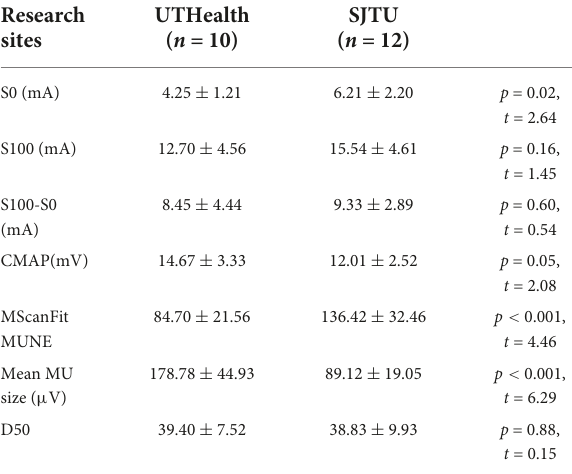
TABLE 2 CMAP scan and MUNE parameters of the APB in two research centers using the same stimulus protocol (data in mean ± standard